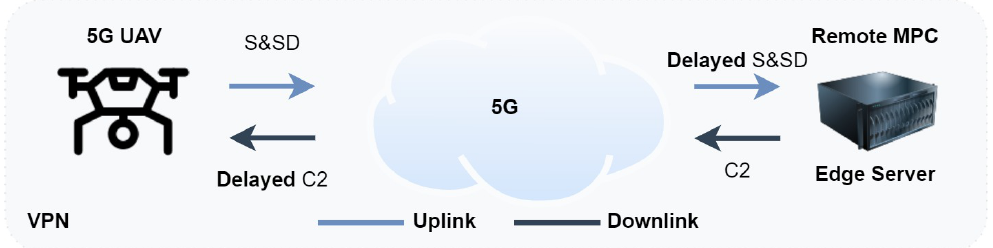
Figure 6. The 5G-UAV autonomous mission architecture. The remote controller is located in the edge cloud. An MPC controller is operating in the cloud and sends real-time control back to the UAV. The communication is established over 5G. S&SD: state and sensor data; C2: control and command data.